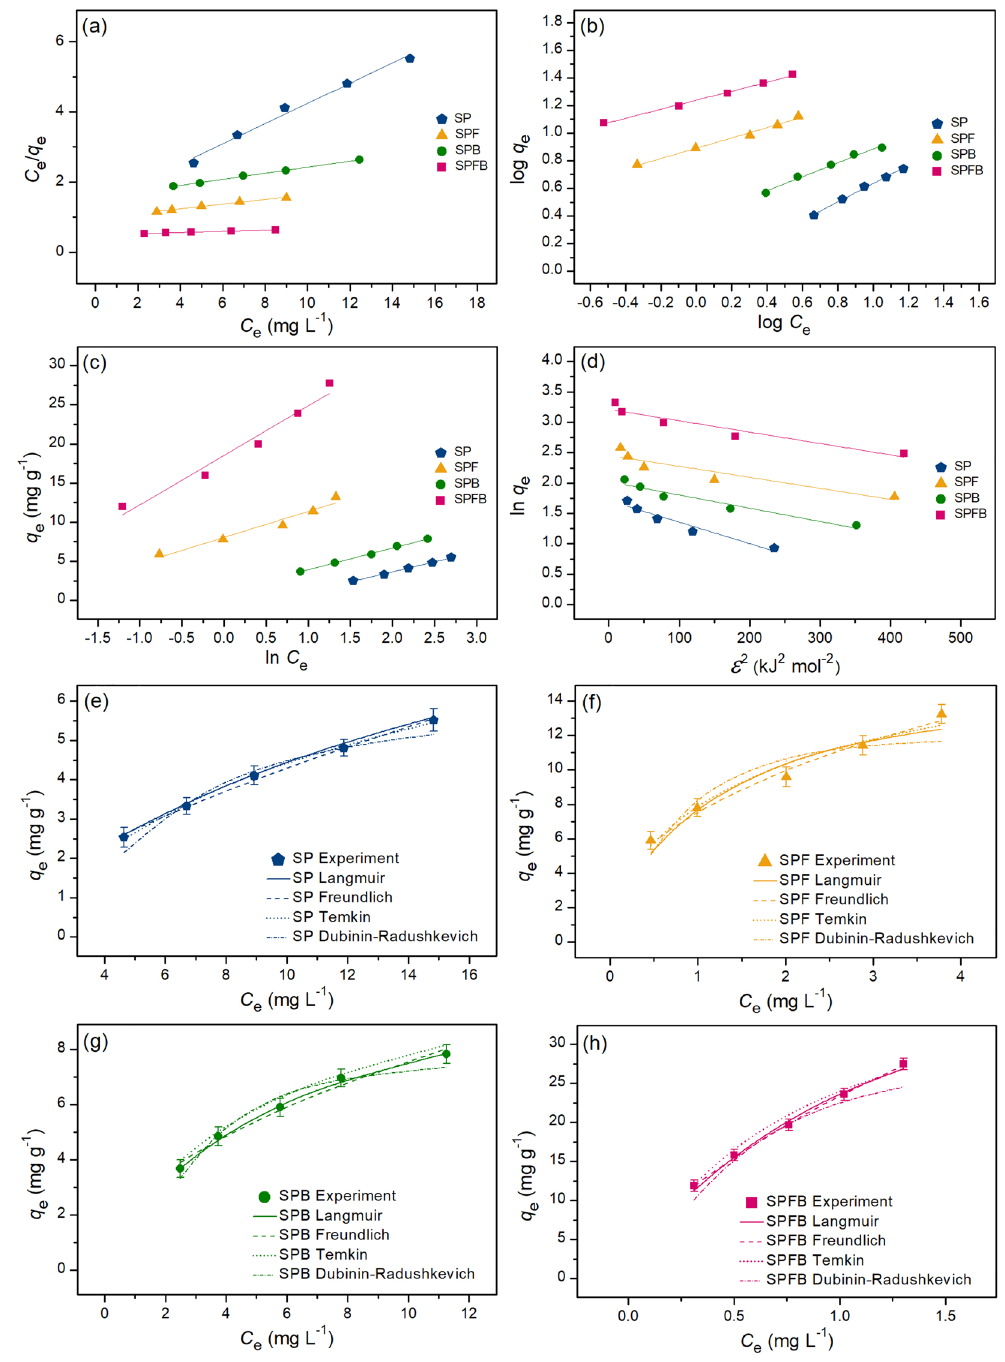
Figure 6. Graphs of ( a ) linear Langmuir, ( b ) linear Freundlich, ( c ) linear Temkin, ( d ) linear Dubinin– Radushkevich, and ( e – h ) nonlinear adsorption isotherms of sawdust powder (SP), sawdust powder doped iron (III) oxide-hydroxide (SPF), sawdust beads (SPB), and sawdust powder doped iron (III) oxide-hydroxide beads (SPFB) for lead